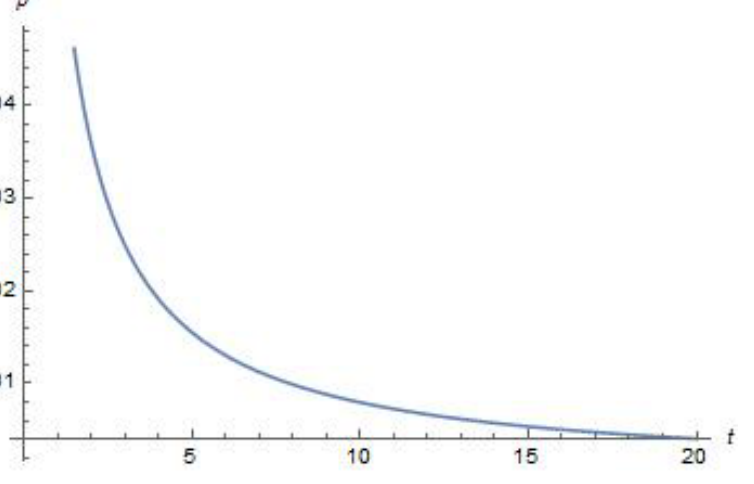
Figure 3. Energy density ρ (in Gyr − 2 ) against time t (in Gyr ).